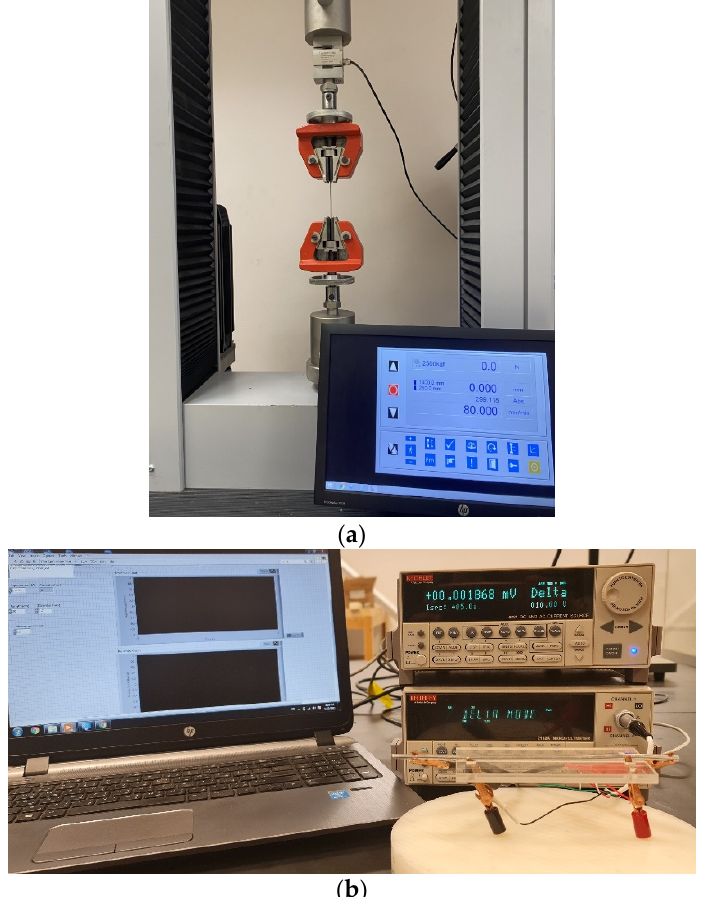
Figure 1. ( a ) The tensile testing setup showing the gripped 3.5 mm wire. The test was performed at room temperature via software to control the crosshead speed; ( b ) in-house electrical resistivity setup utilizing a current source and nanovoltmeter connected in Delta mode. The LabVIEW-controlled resistivity test was performed using the four-point method.